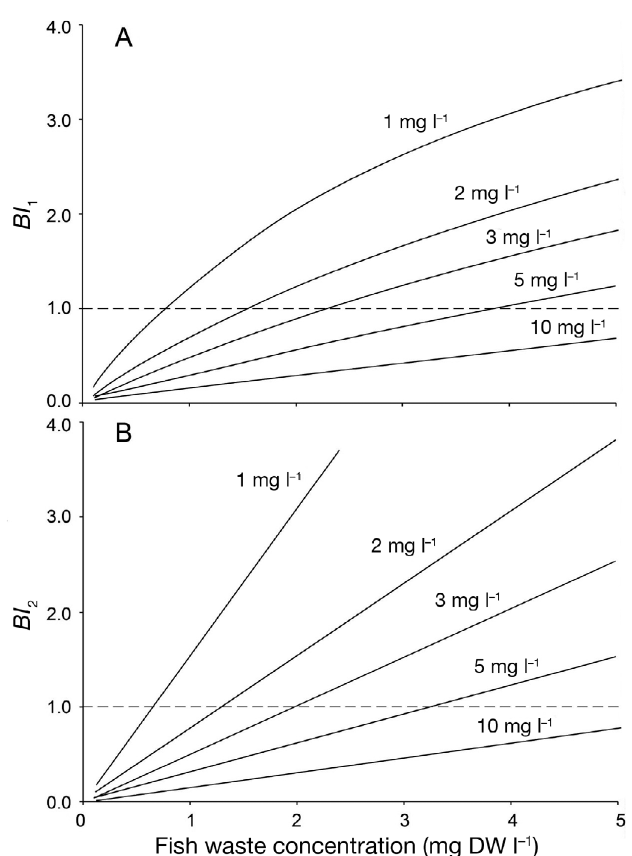
Fig. 2. Relationships between suspended fish waste dry weight (DW) concentration and the 2 mussel biomitigation indices (see Eqs. 3 & 4 under ‘Biomitigation potential’ in the main text). The different lines show results for seston concen- trations of 1, 2, 3, 5, and 10 mg DW l −1 , assuming 77 and 40% organic contents for the fish waste and seston, respectively, and wastes are available 50% of the time. A biomitigation in- dex ( BI) less than unity (dashed line) represents non-biomiti- gation conditions where mussels produce more organic wastes as feces than they absorb from the ingested fish